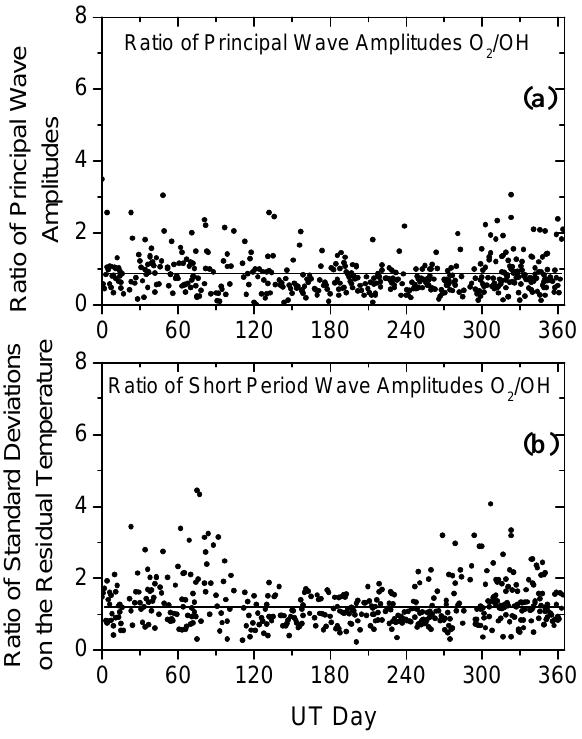
Fig. 4. The top panel shows the ratio of the principal wave am- plitudes in O 2 to the OH data (normalized to their mean values). The ratios of the standard deviations (O 2 /OH) normalized to their mean are plotted in the bottom panel. Solid lines in the plots rep- resent 95% confidence levels. One could see the difference in the seasonal pattern in the growth factors between both the plots with smaller period waves, having notable variability from the equinox to the summer